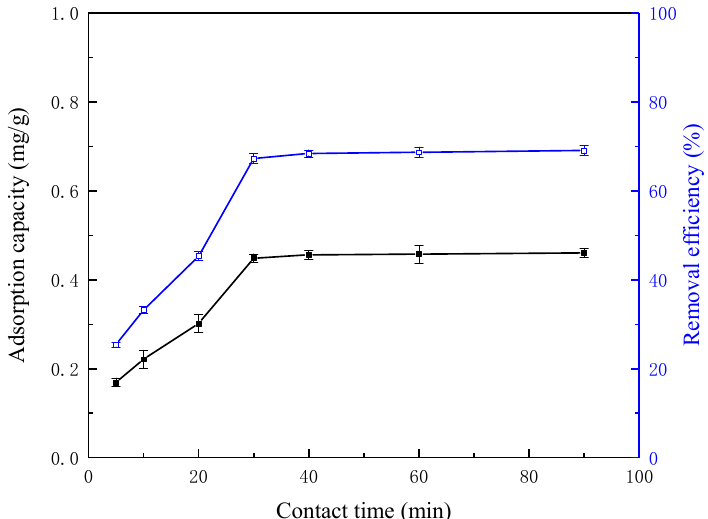
Figure 6. The e ff ect of oscillation adsorption time on pyridine removal e ffi ciency and adsorption Figure 6. The effect of oscillation adsorption time on pyridine removal efficiency and adsorption capacity of capacity of pyridine.